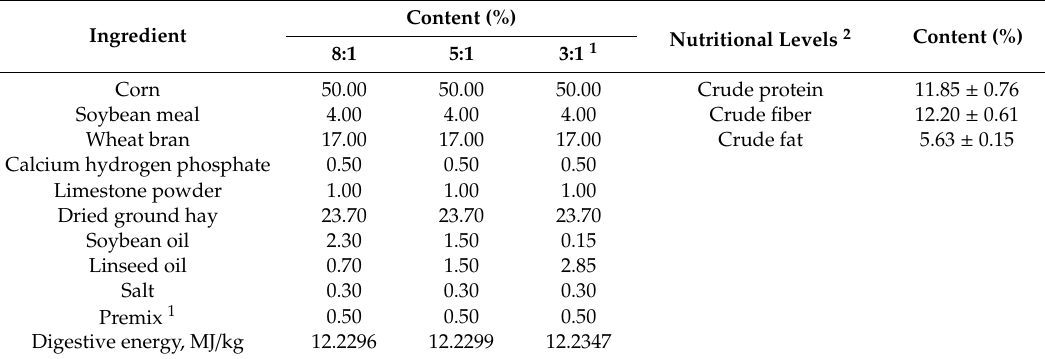
Table 1. Ingredient composition and nutritional levels of the diet (air-dry